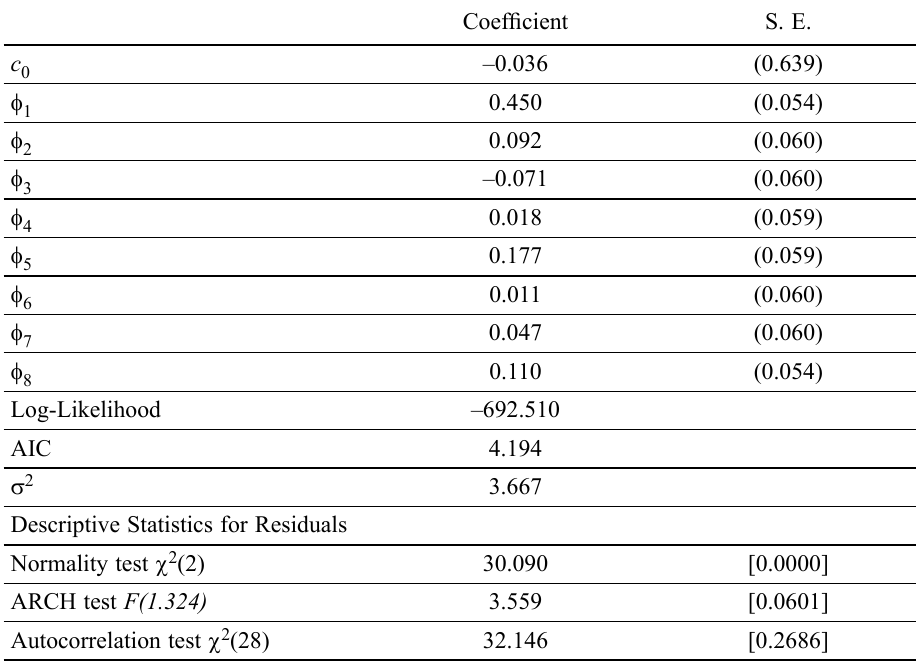
Table 2. Maximum likelihood estimation of ARIMA (8, 0 ,0) model: